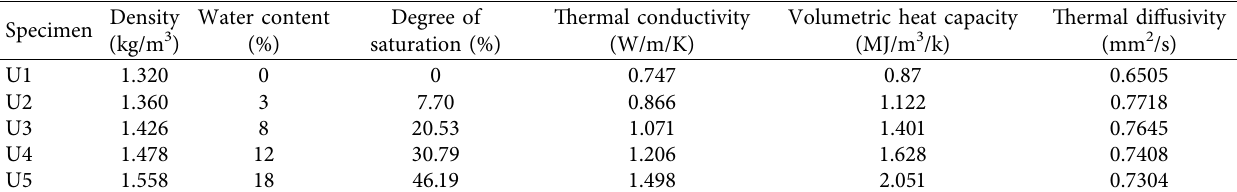
Figure 1: Diagram of the experimental system. Table 2: Initial state variables and thermal properties of soil